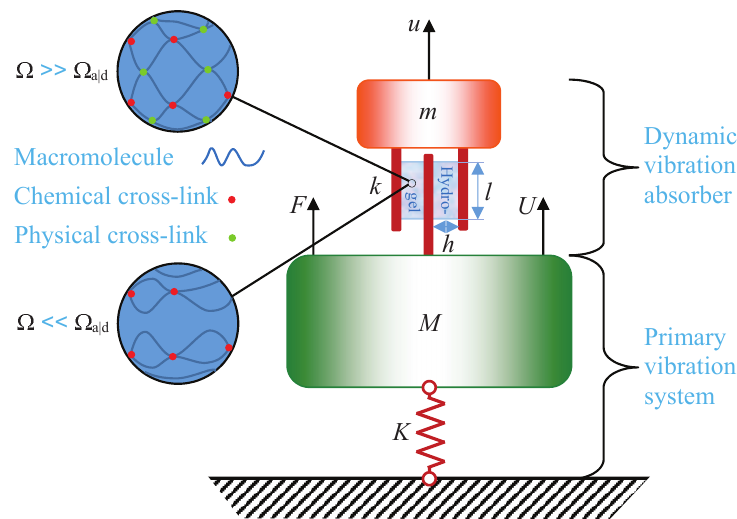
Figure 1. A primary vibration system attached to a dynamic vibration absorber consisting of tough, single polymer network hydrogel blocks in a simple shear configuration with both chemical and physical